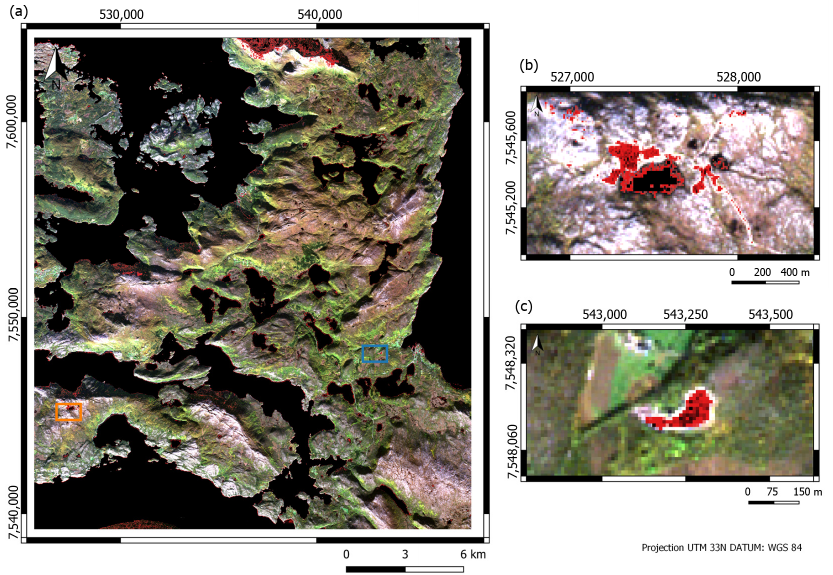
Figure 15. Result for BR 4/8. Pixels higher than 0.70 are represented in red colour. ( a ) Overview of the study area where Håkonhals mine is highlighted by the orange rectangle and Jennyhaugen mine by the blue rectangle. ( b ) Håkonhals mine in focus. ( c ) Jennyhaugen mine in focus.